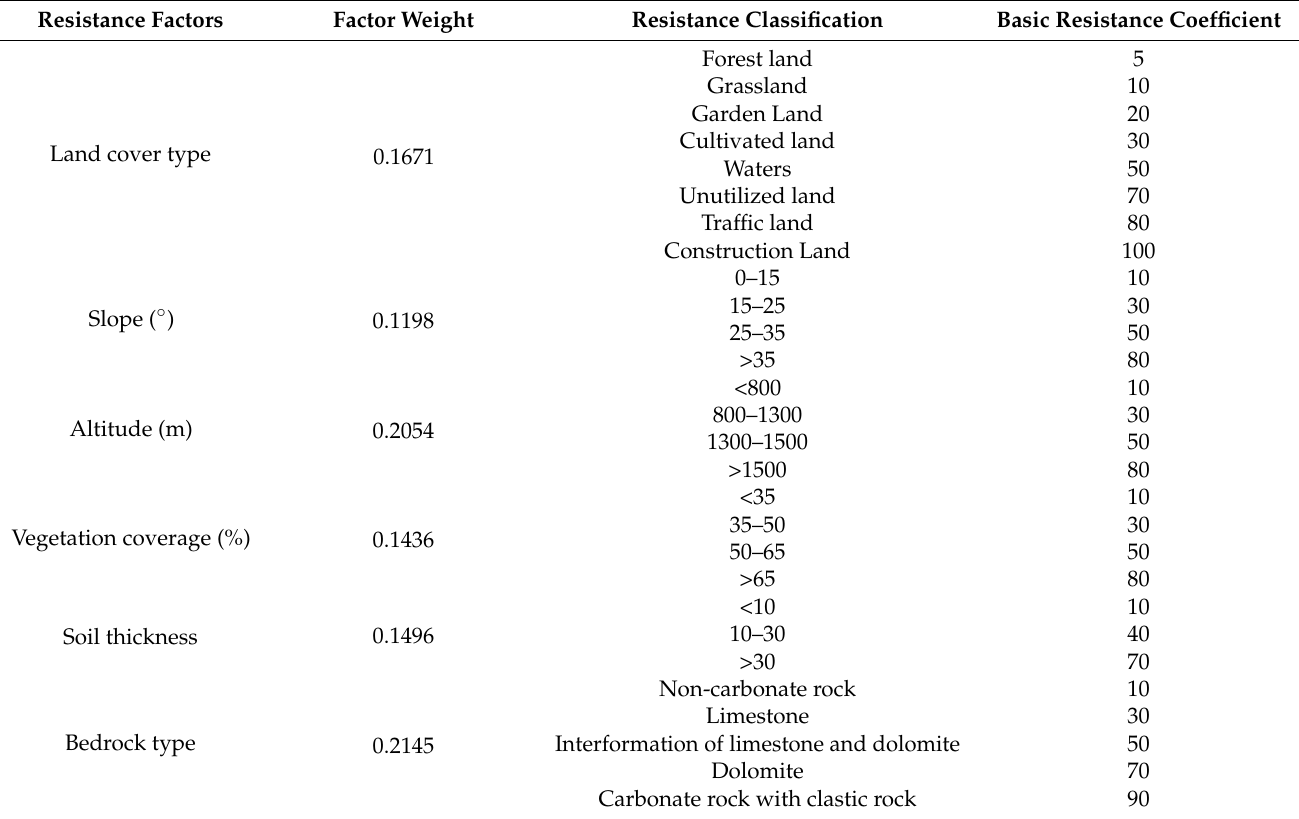
Table 2. Resistance factor and weight in the study